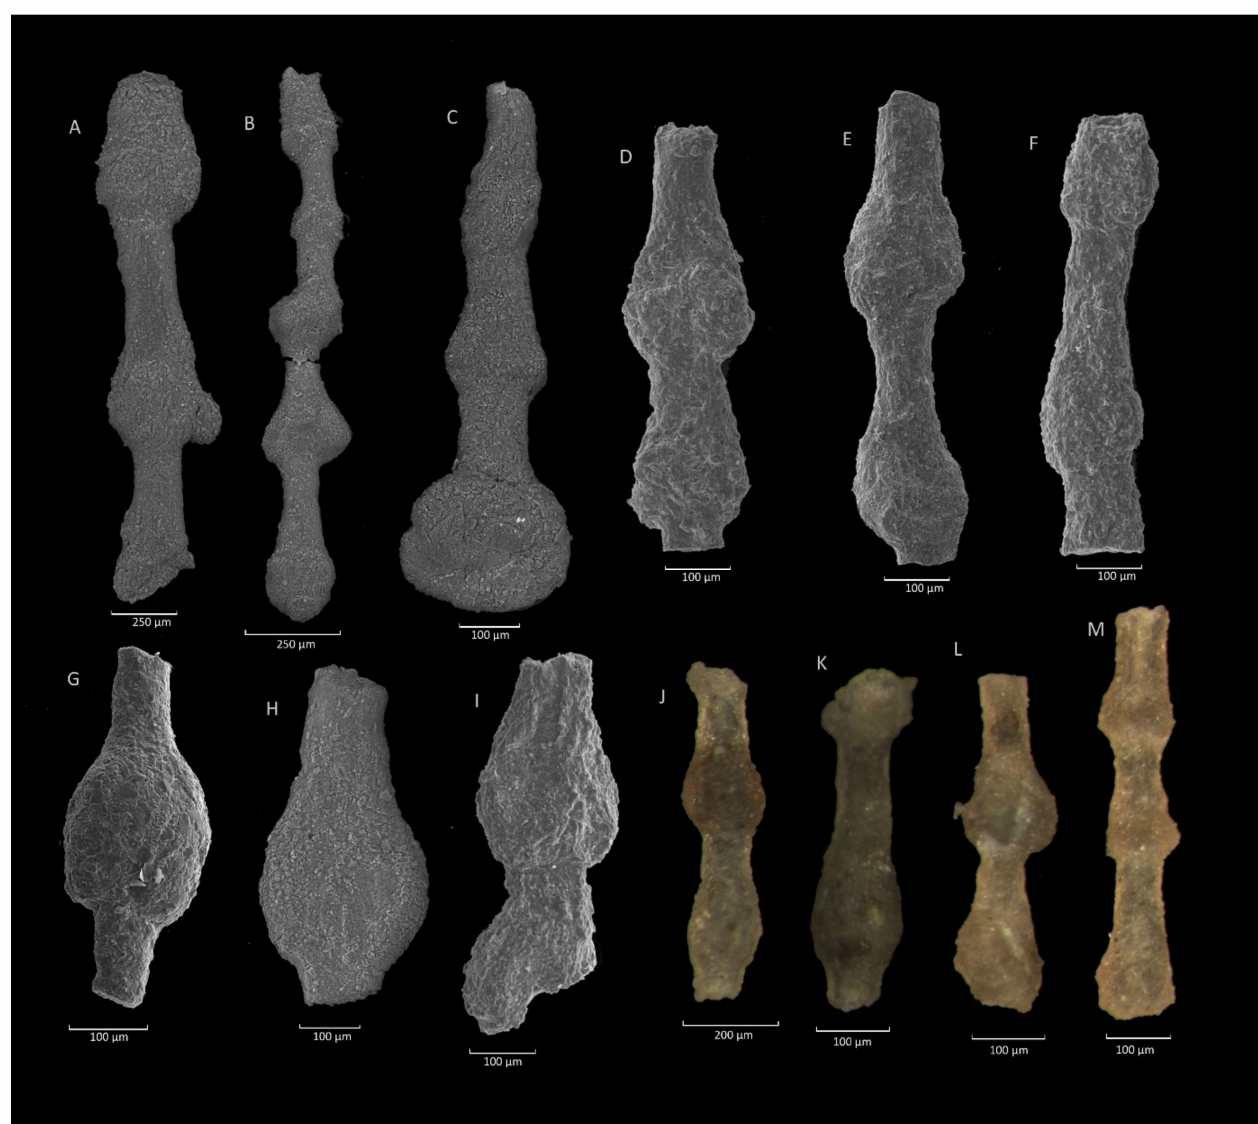
Figure 9. Caudammina excelsa (Dyl ˛a˙zanka). ( A – C , H , L , M ): Ropica section; ( D , F ): Rzyczki section; ( E , I ): Mutne section; ( G ): Stradomka section; ( J , K ): Jaworzynka